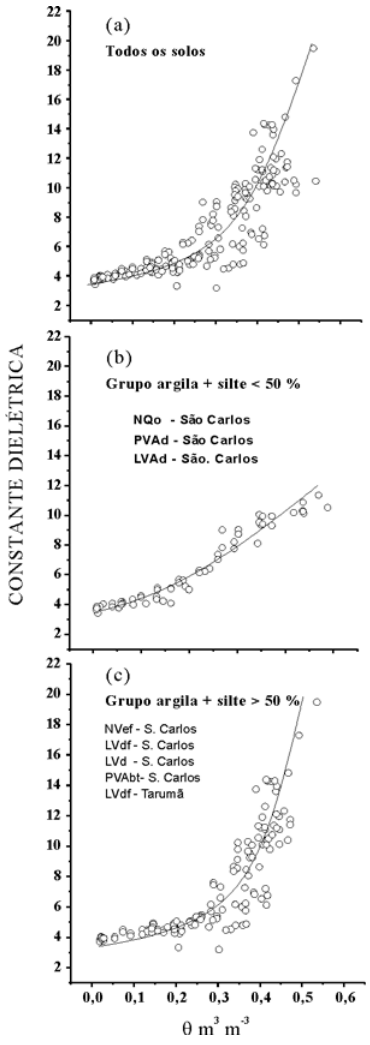
Figura 5. Respostas da constante dielétrica considerando a umidade com a sonda espiral de TDR, medida com os dois equipamentos (TDR 1502 C e TDR-100), para todos os solos (a) e os grupos de solos com argila + silte < 50 % (b) e argila + silte < 50 % (c), com amostras deformadas, em laboratório. O ajuste dos dados foi realizado com a função θθ θθθ = a + b εε εεε + c/ εε εεε 2 , e os coeficientes do ajuste são apresentados no quadro